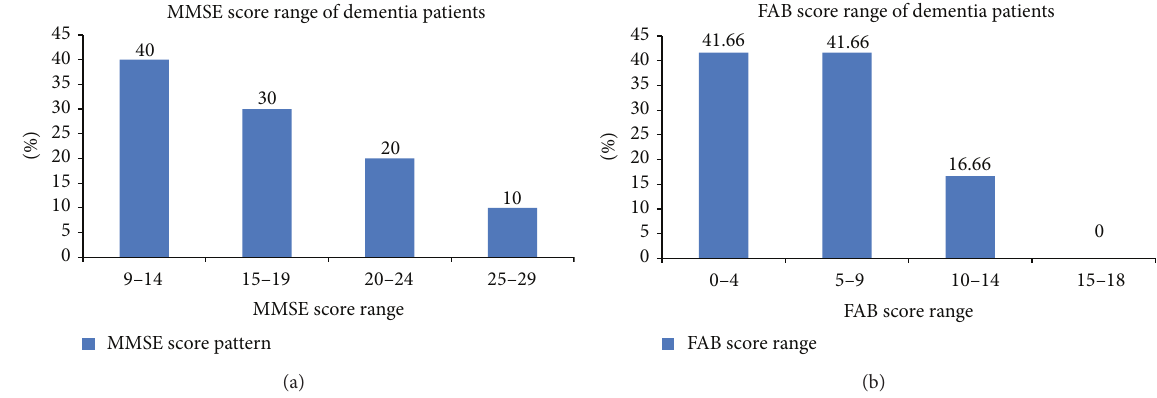
Figure 2: (a) depicts the MMSE score pattern of dementia cases. (b) depicts FAB score pattern of dementia cases.